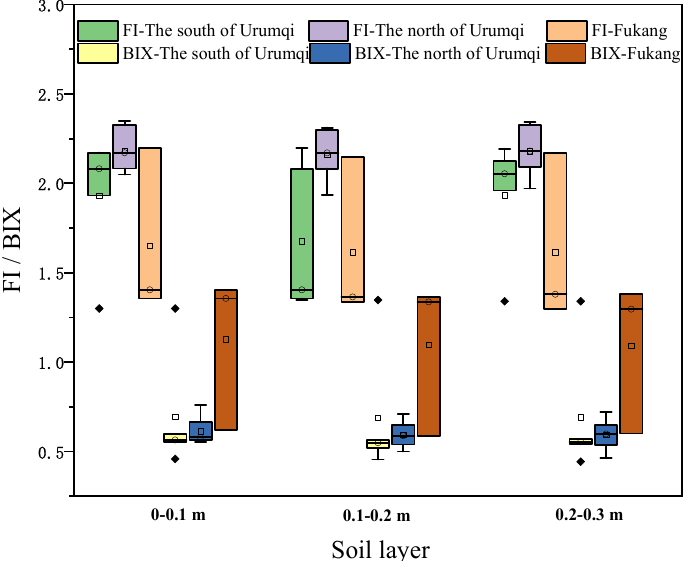
Figure 3. Average fluorescence intensities of different soil depth on different districts. The fluorescence index (FI) often indicates the sources of DOM. Generally, there are two main sources of plant and microbial metabolites with FI values of 1.4 and 1.9, re- spectively[40,41].When FI < 1.4, DOM is mainly from plant sources. When FI is between 1.4 and 1.9, DOM is from both plant and microbial metabolites. While FI > 1.9, DOM is